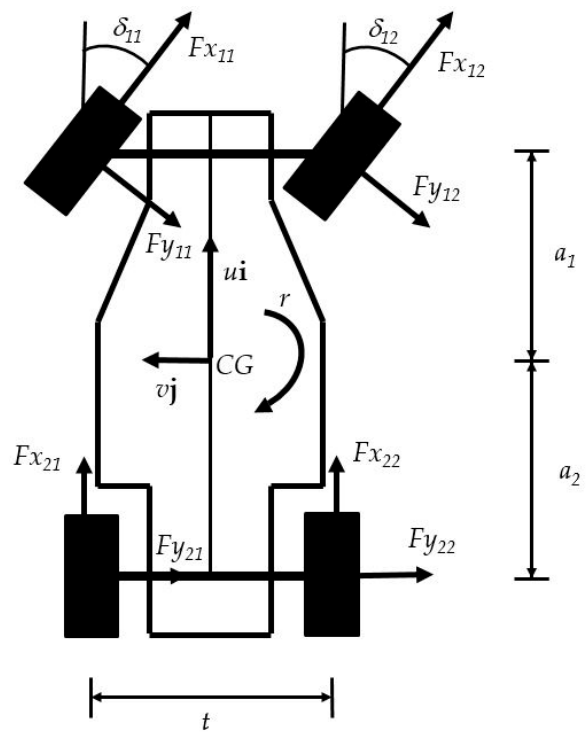
Figure 2. Dynamic modelling of a vehicle, with road-tyre force [113].